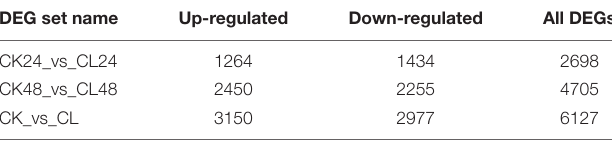
TABLE 1 | Statistics of differentially expressed genes.